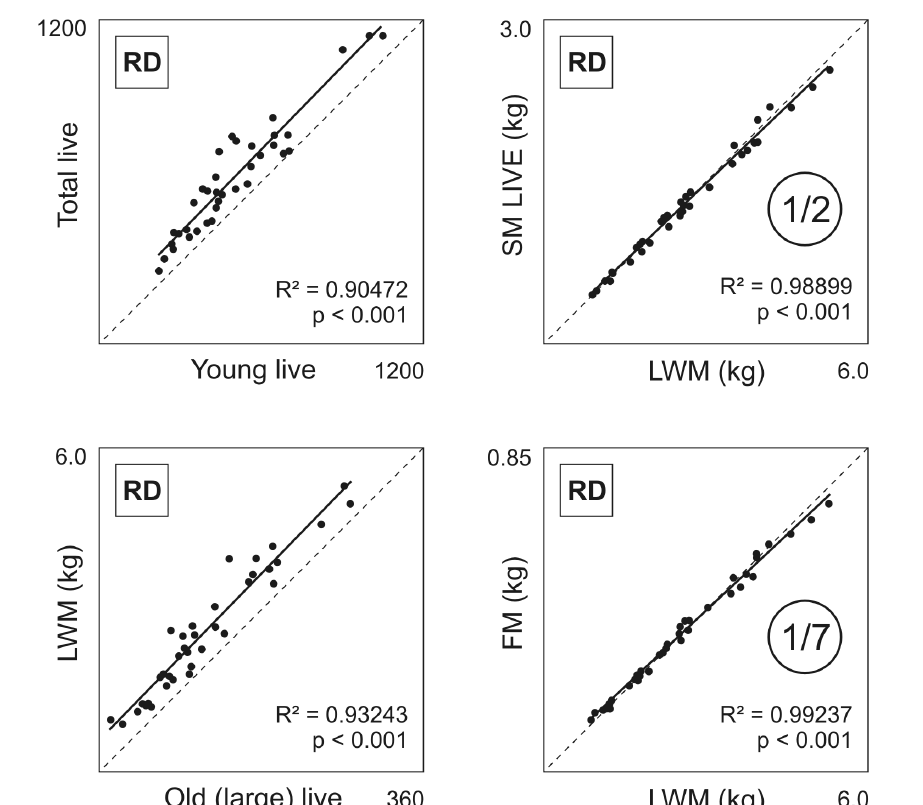
Figure 13. Interrelations between selected mussel density attributes per site and year (N = 36 reefs). Given are linear relationship, coefficient of determination (R²) and significance level (p). Proportional reference line (dotted) and proportions indicated (circles). See text for all other interrelations. Density metrics and density attributes according to Figure